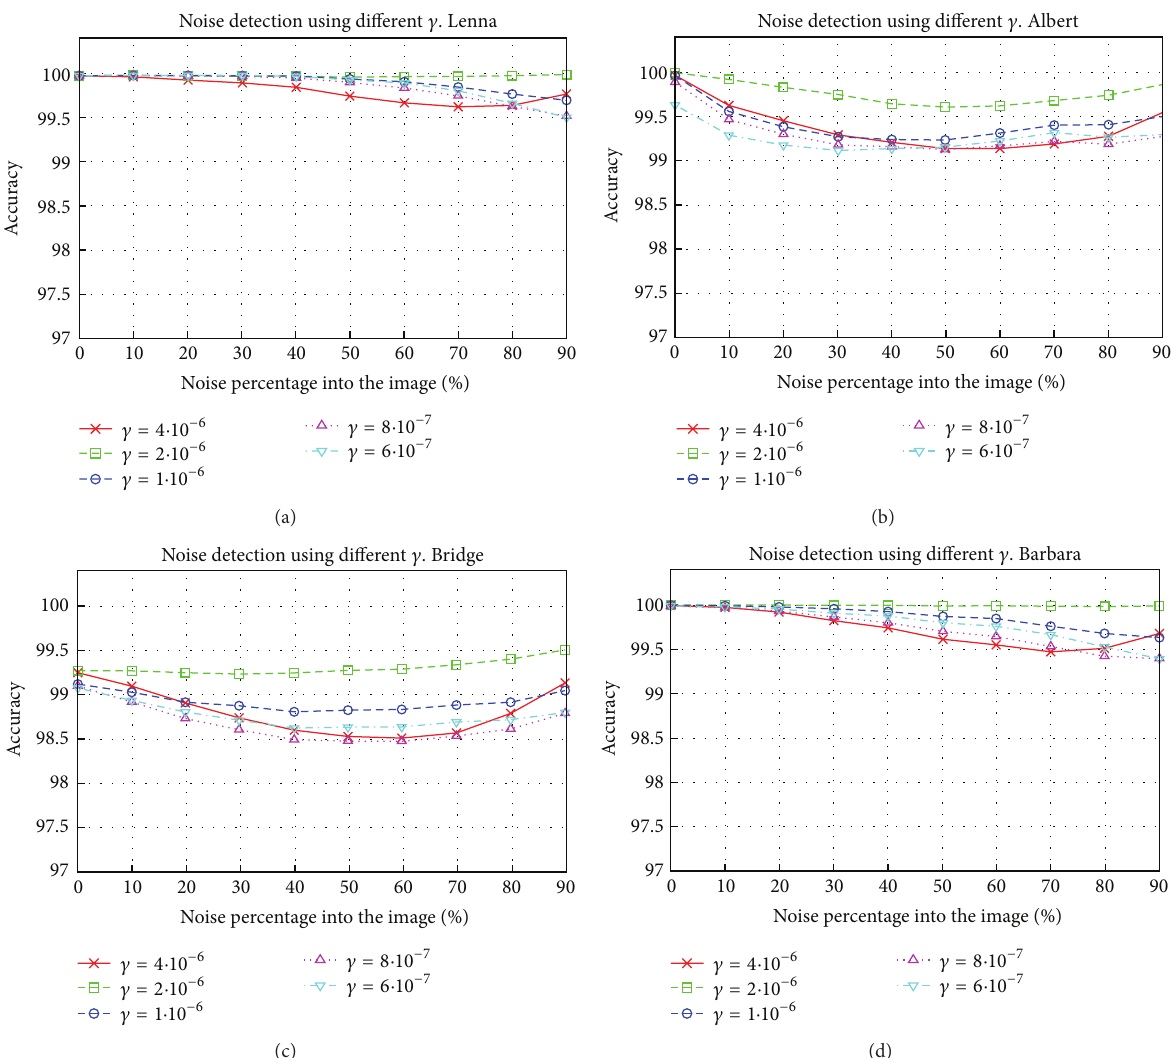
Figure 5: Noise detection results for different values of 𝛾 . The parameter presented is the accuracy that is related to the percentage of noise in the image. The results are shown for the Lenna, Albert, Bridge, and Barbara images.